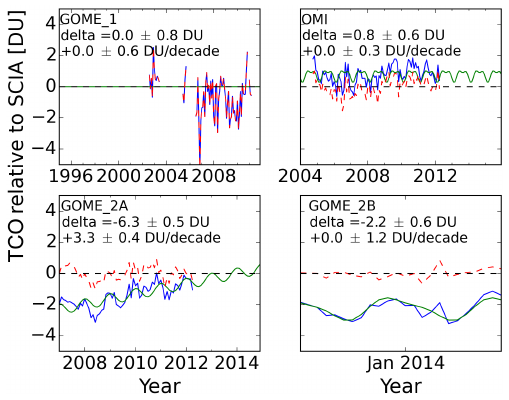
Figure 3. Average difference between the reference (SCIA- MACHY) and the other sensors (blue), the fitted functions (cor( t )) in green and the difference to the harmonised data in red (r( t )). Table 1. Parameters of Gaussian fits to the difference between the other instruments and the reference (SCIAMACHY). For GOME no correction was applied, hence only one set of parameters is